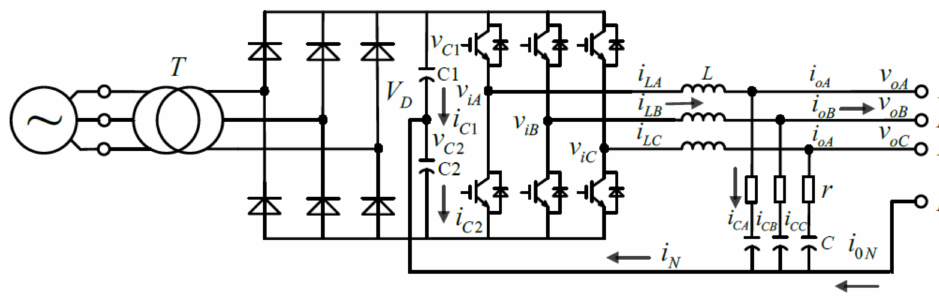
Figure 1. Main circuit of VSSG.